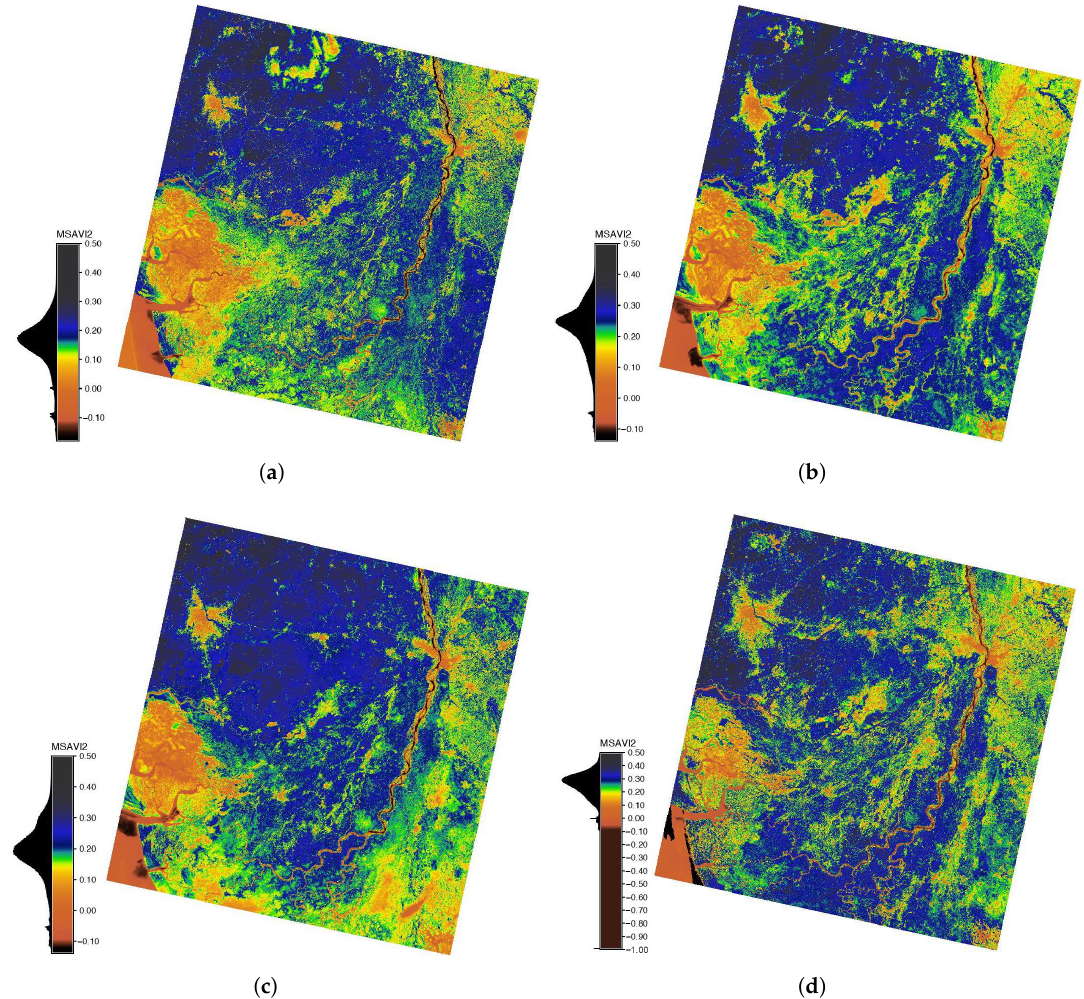
Figure 10. MSAVI2 computed from the Landsat 8-9 OLI/TIRS images of Niger River Delta for four years: ( a ) 2013, ( b ) 2015 ( c ) 2021, ( d )